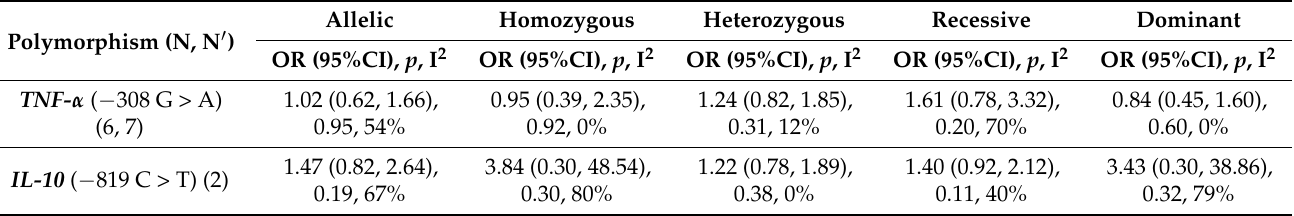
Table 8. Sensitivity analyses removing the studies with a deviation of HWE in their controls for TNF- α ( − 308 G > A) and IL-10 ( − 819 C > T) polymorphisms.